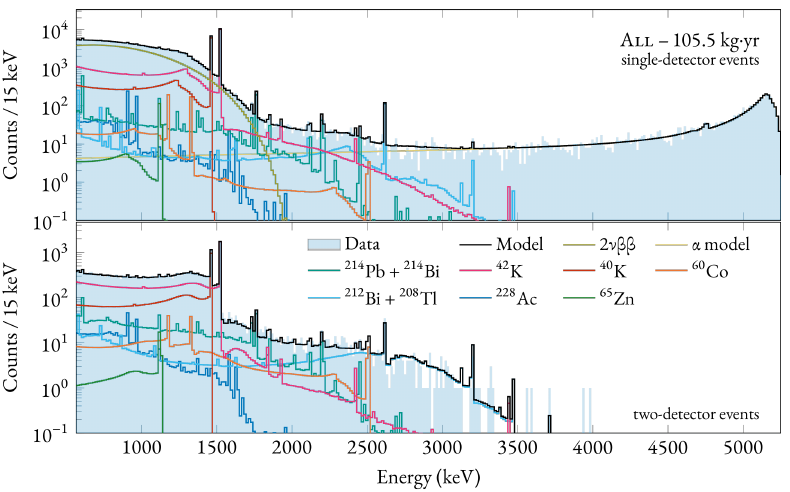
Figure 25. The spectral decomposition of the Phase II global data set in the labeled background sources, for events firing a single detector ( top ) and two detectors ( bottom ): as expected the α s are removed by the coincidence